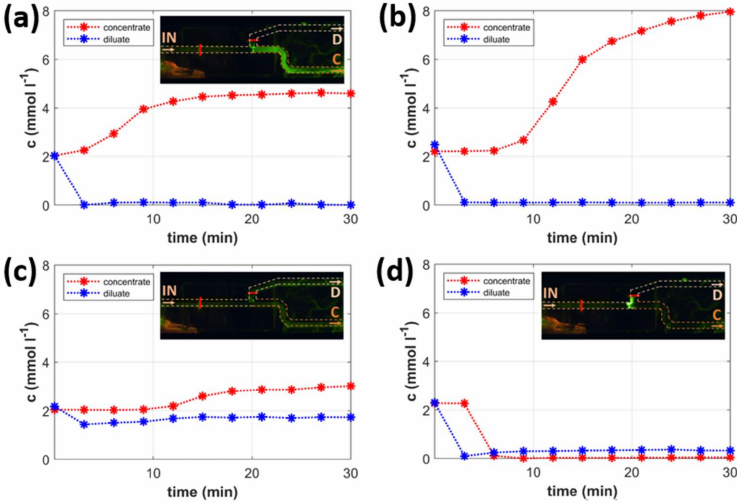
Figure 2. Types of chip operation: the graphs capture the measured time dependencies of the KCl concentrations in the diluate and concentrate stream, the insets the signal of fluorescein: ( a ) continuous desalination ( U = 200 V, V D = 20 µ L/min, V C = 5 µ L/min), ( b ) continuous desalination ( U = 250 V, V D = 20 µ L/min, V C = 2 µ L/min), ( c ) unsuccessful operation ( U = 50 V, V D = 15 µ L/min, V C = 2 µ L/min), and ( d ) desalination by accumulation ( U = 250 V, V D = 10 µ L/min, V C = 5 µ